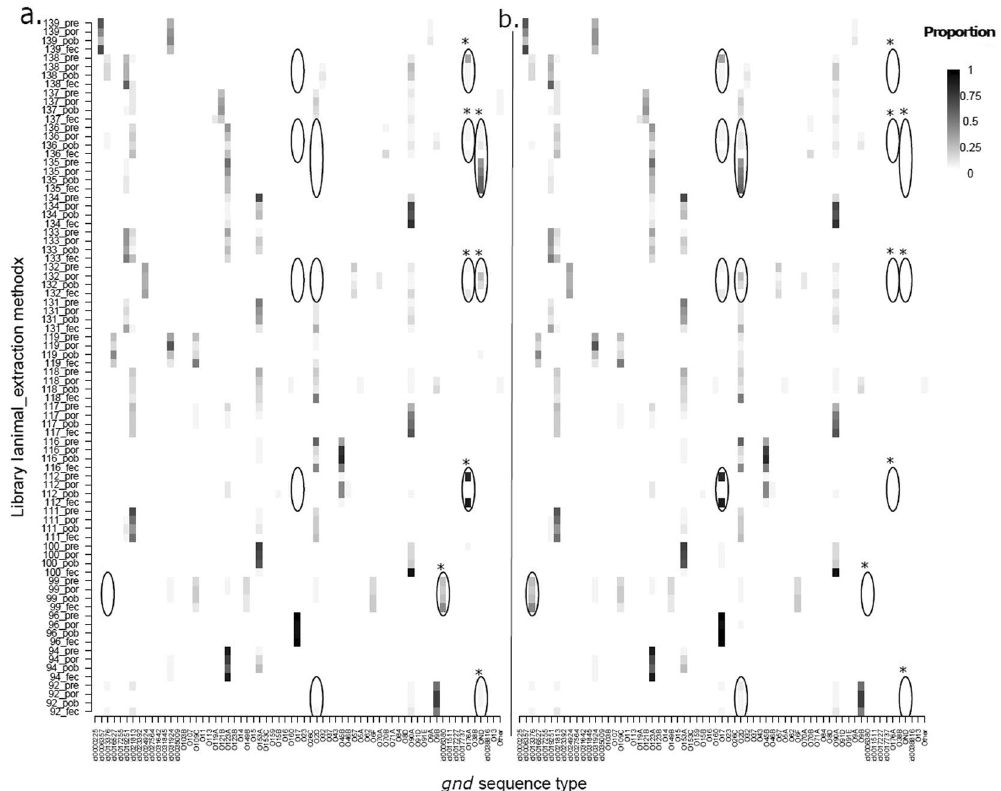
Figure 3. E . coli communities detected from calf faeces. Heat map to illustrate the relative proportions of gSTs along x axes (where present in sample library at > 1% abundance) determined from amplicon libraries (n = 80) generated from template DNA prepared using four extraction methods (pre-enrichment, ‘pre’; post- enrichment, boiled lysate, ‘pob’; post-enrichment, spin-column, ‘por’ and faecal, ‘fec’) for each of 20 animals, along y axes. Proportions of gSTs associated with each animal and extraction method analysed using ( a ) the EC model and ( b ) clustering at the 99.6% similarity level (one SNP difference) using CD-HIT. Both methods reveal limited impact of sample type or DNA extraction method on intra-host E . coli community variation from faeces and recto-anal mucosal swab samples. Black ellipses represent gSTs (e.g. O17 and O176, or OND and O2D) that differ by one SNP. gSTs marked with an asterisk using the EC model ( a ) are combined with other gSTs after cluster analysis at the 99.6% similarity level (one SNP) ( b ). Squares of increasing shading represent gSTs at proportions from 1% (very pale) to 100% (black) associated with individual animal and extraction method, i.e. 80